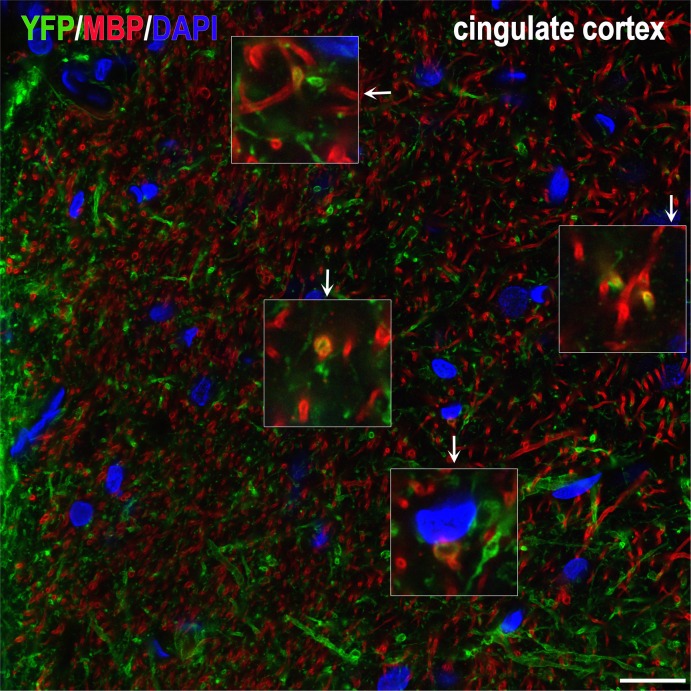
Myelinated human axons deeply into host cortex.This section was immunostained and imaged exactly as section in Fig 12. Here we illustrate a terminal field of transplant-derived neurons in cingulate cortex. Note the occasional double-labeled profiles, suggesting a low degree of myelination of transplant-derived axons away from the graft. Insets are magnifications of profiles in main frame linked with arrows. Scale bar: 20μm.